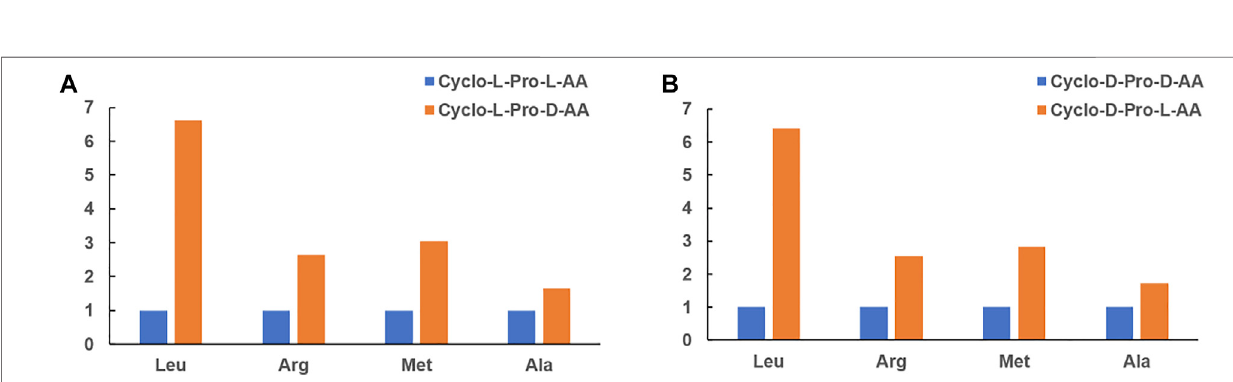
Frontiers in Astronomy and Space Sciences |